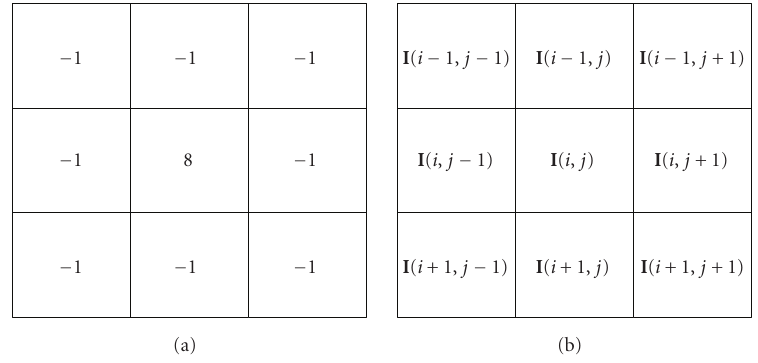
Figure 7: (a) Point detection kernel and (b) 3 × 3 block centered around pixel I ( i , j ) .